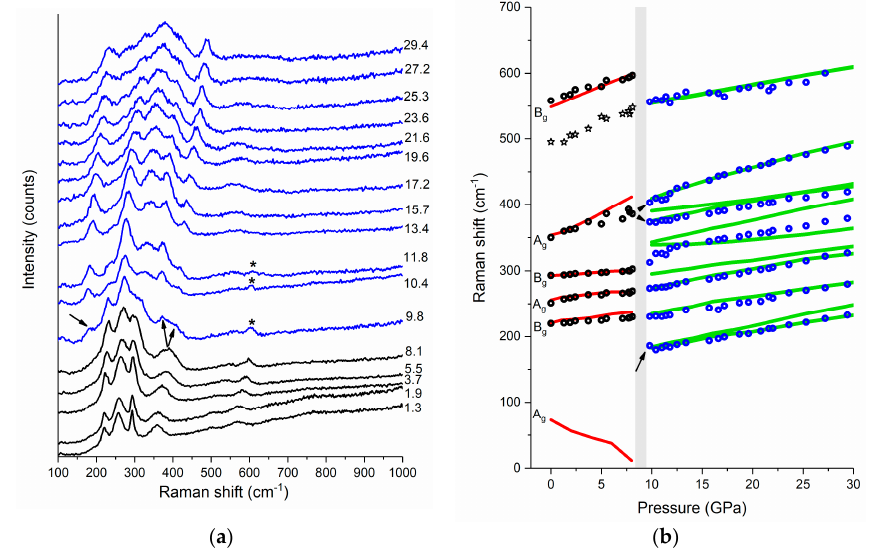
Figure 3. ( a ) Raman spectrum of powder CuF 2 at selected pressures (their values are given in